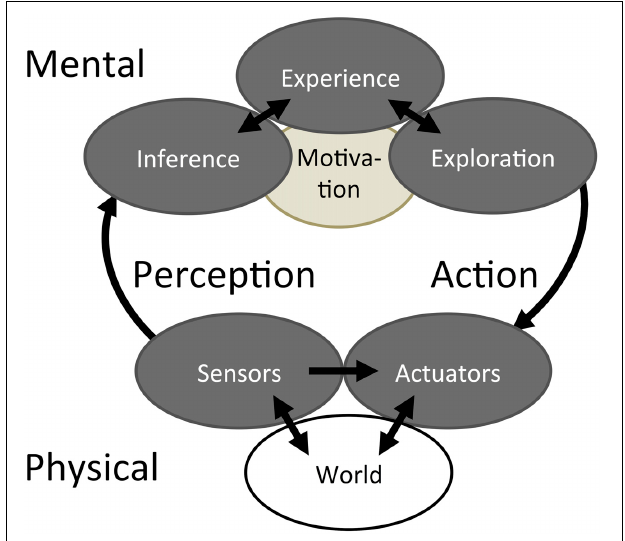
FIGURE 1 | Bayesian Action&Perception. A haptic system interacts with the world through a mechanical Interface that provides access to both Sensors and Actuators. These Physical components are connected to Mental functions through the activities of Perception and Action. The Mental functions consist of Bayesian Inference and Bayesian Exploration, both capable of accessing and adding to an associative memory of Experience according to the Motivation to achieve certain